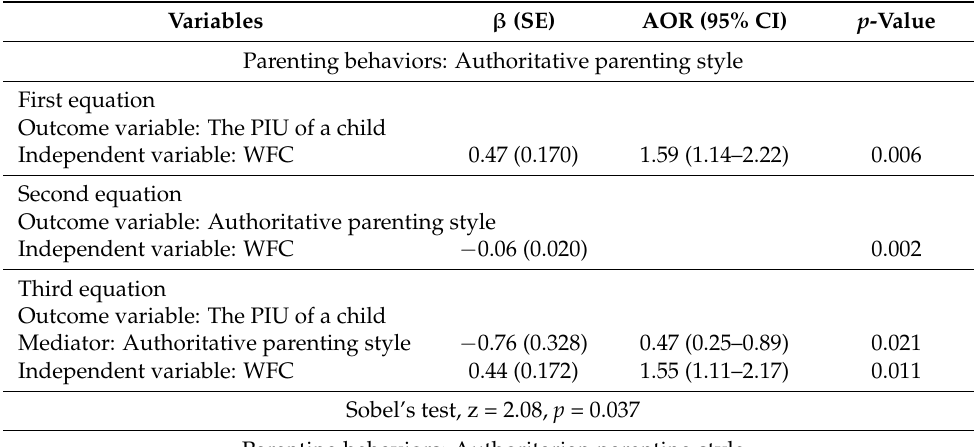
Table 3. Hypothesis testing for a mediating effect of parenting style on the association between WFC and the PIU of a